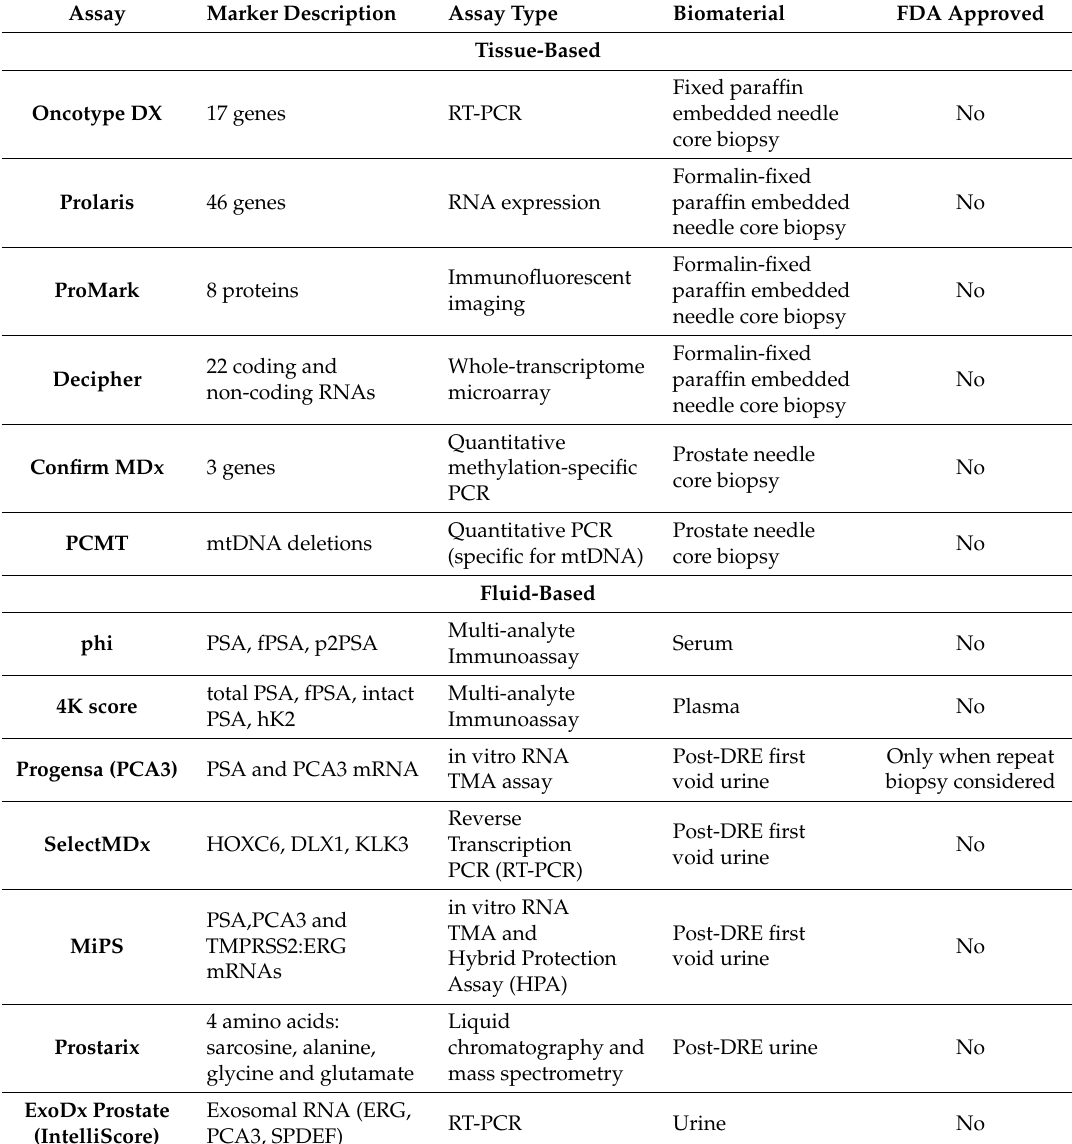
1 Table adapted from Falzarano et al.